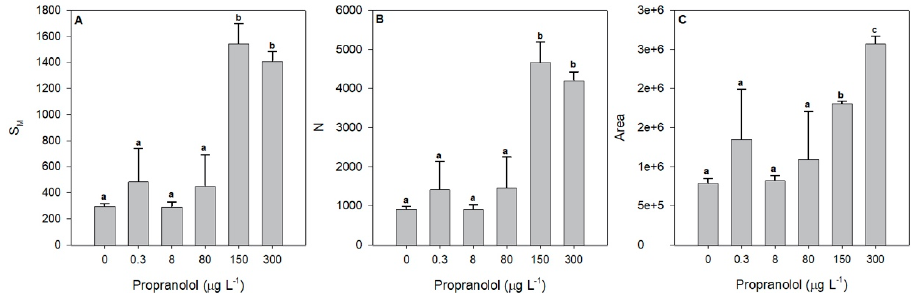
Figure 3. Absolute ( A ) and relative ( B ) phenomological energy fluxes (ABS / CS—absorbed energy flux per cross-section; TR / CS—trapped energy flux per cross-section; ET / CS—electron transport energy flux per cross-section; DI / CS—dissipated energy flux per cross-section and RC / CS—number of available reaction centers per cross-section) and ( C ) reaction centre density (RC / ABS) in Phaeodactylum tricornutum cultures exposed to di ff erent propranolol concentrations (average ± standard error, n = 3, letters denote di ff erences at p < 0.05).